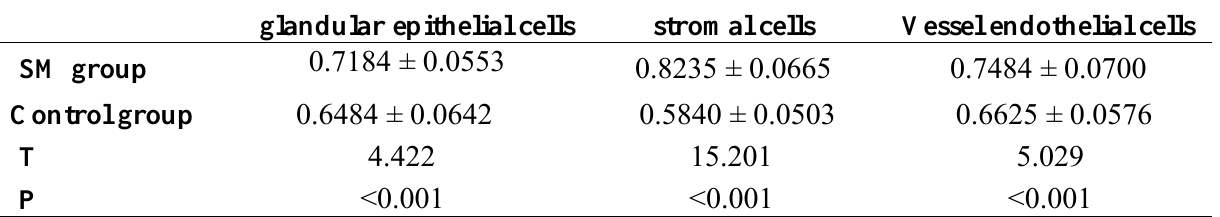
Table 4. The level of the nucleoplasmic ratio of NF- κ B p65 (mean ± s) in the different cells in